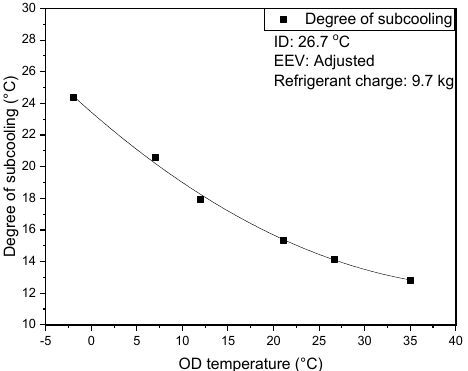
Figure 5. Degree of subcooling of conventional cooling system according to OD air temperature. The power consumption rate decreases as the OD air temperature decreases due to the decrease in the condensing temperature and pressure of the cooling system. The refrigerant mass flow rate, as shown in Figure 7, along with the compression ratio across the compressor reduces, resulting in a decrease in the power consumption of the conventional IDC cooling system as the OD air temperature decreases. As the OD air temperature decreases from 35 ◦ C to − 2 ◦ C, the power consumption decreases from 4.89 kW to 2.76 kW. Figure 6. Saturation temperatures of conventional system according to OD air temperature. The overall COP of the system increases as a result of the increase in cooling capacity and the decrease in power consumption. The COP increases from 3.11 to 7.57 as the OD air temperature decreases from 35 ◦ C to − 2 ◦